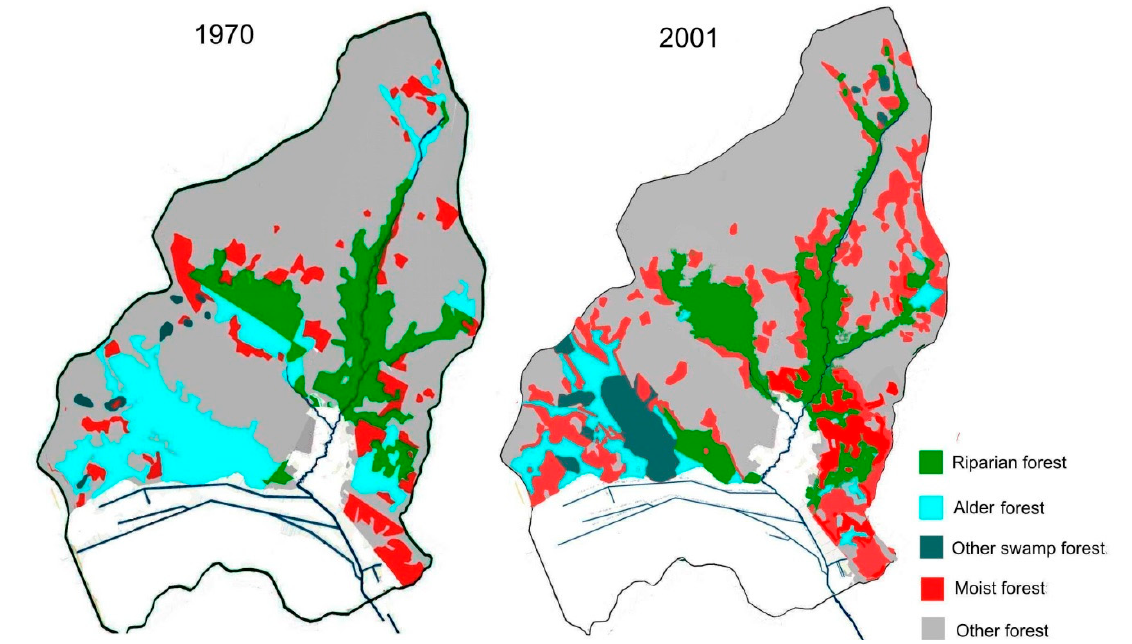
Figure 2. Forest types in the State Forests in the Lebiedzianka catchment in 1970 and 2001.